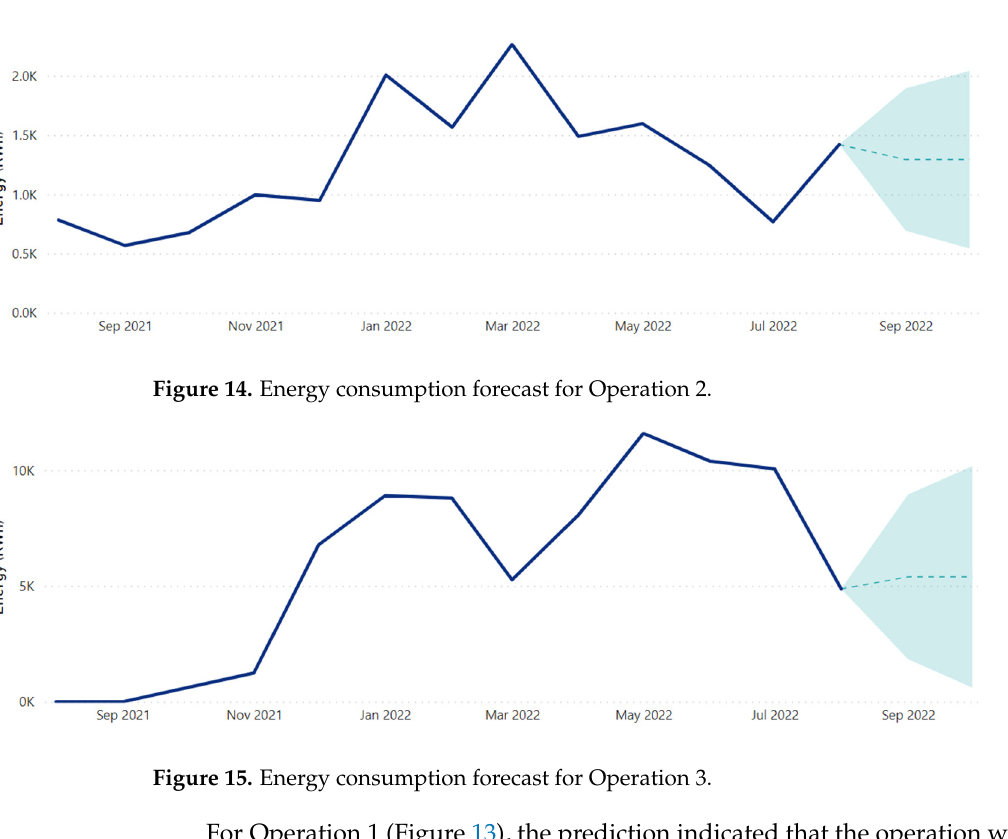
Figure 13. Energy consumption forecast for Operation 1.